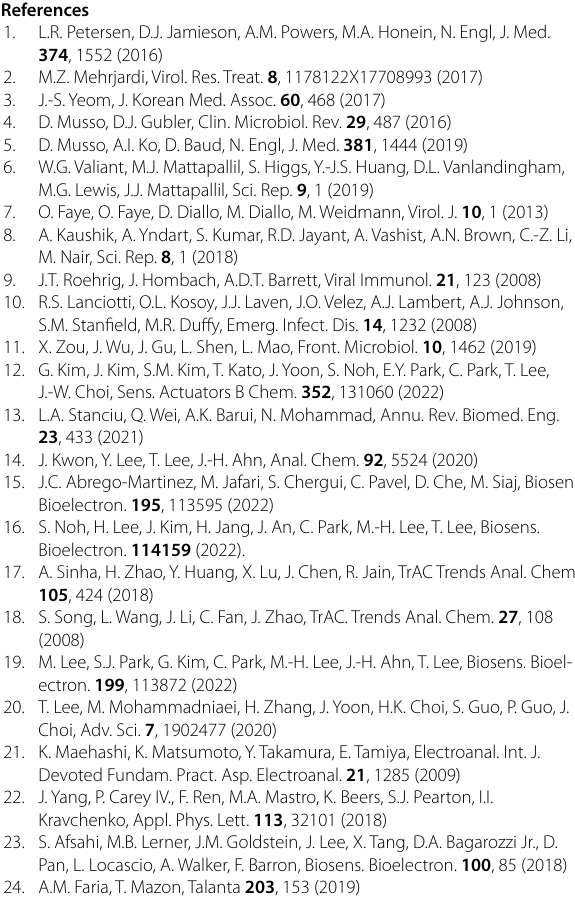
Surface Imprinted